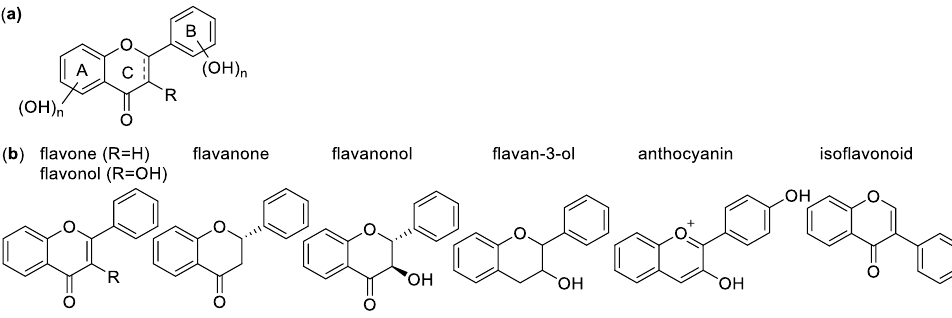
Figure 10. The generic structure ( a ) and major classes of flavonoids( b ) .